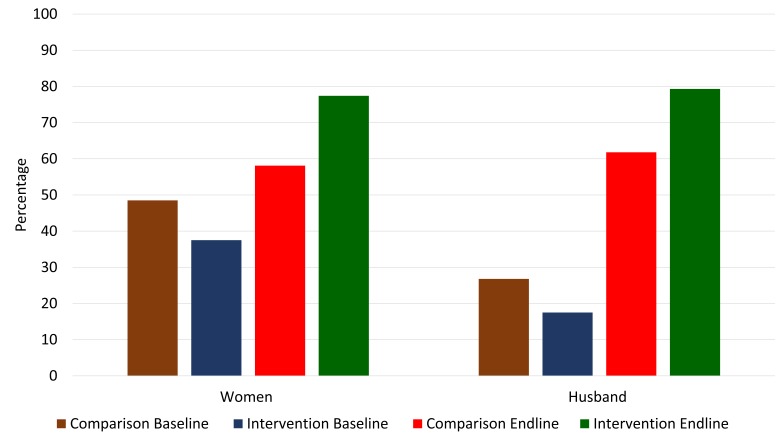
Birth preparedness and complication readiness among women and their husbands; proportions prepared for at least 3 out of 5 components.